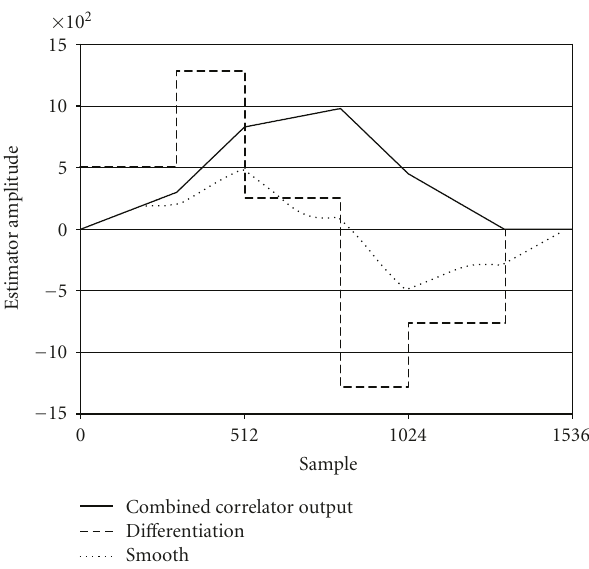
Figure 2: Correlation derivative and smoothed derivative functions (ideal timing at sample